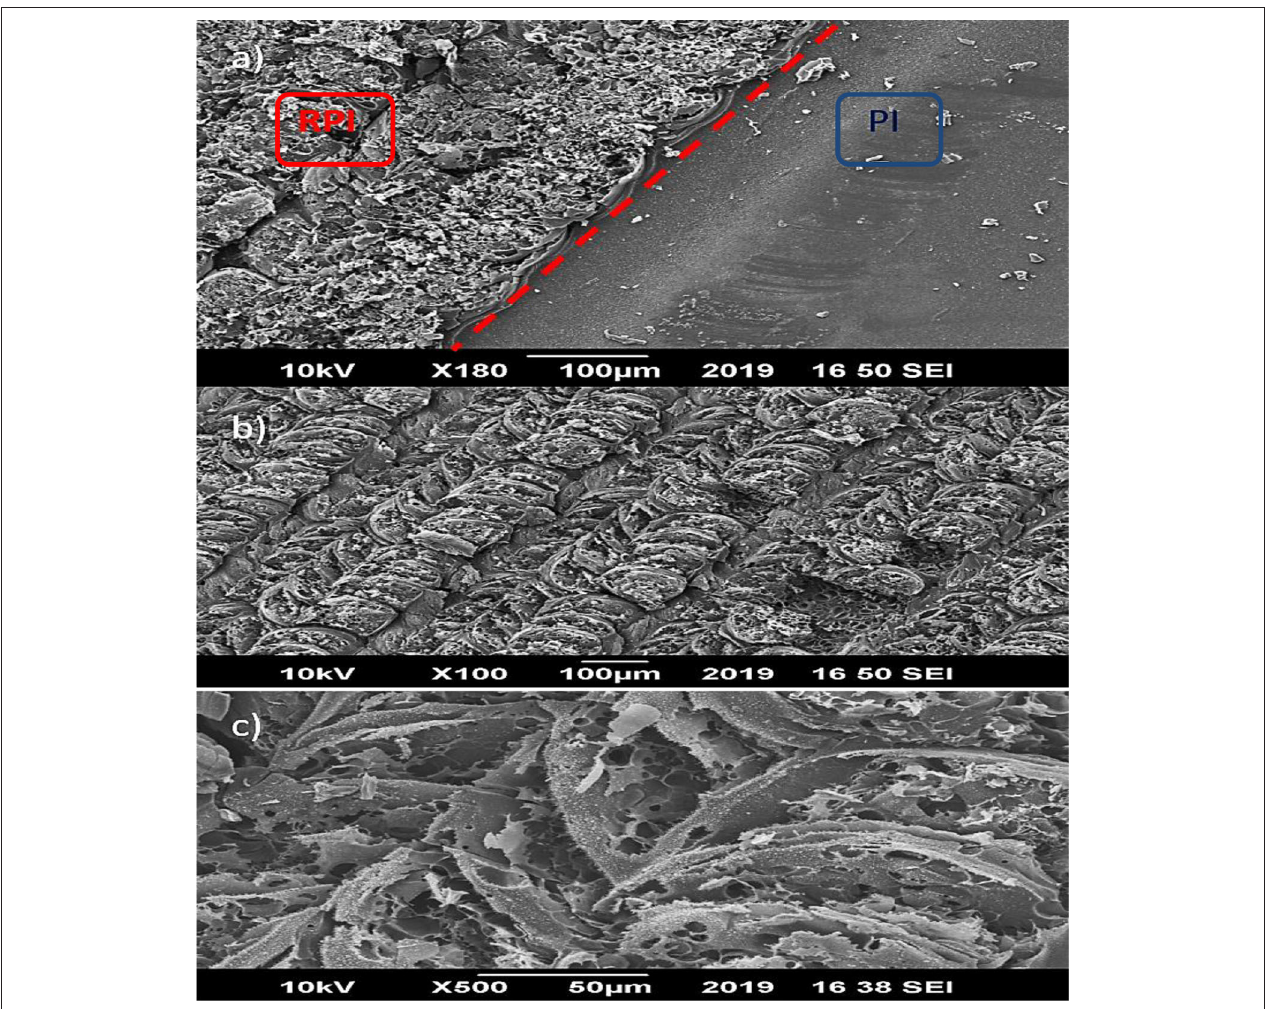
FIGURE 3 | (a) SEM image of irradiated PI at 164 mW laser power. The area on the right-hand side of the red dotted line represents the nonradiated PI and the area on the left side of the dotted line represents the LRPI region. (b) Rough surface area of LRPI on top of PI substrate is shown as a result of laser irradiation. (c) Highly magnified image showing meso-macropores on the walls of LRPI and interconnection of carbon flakes with each other.